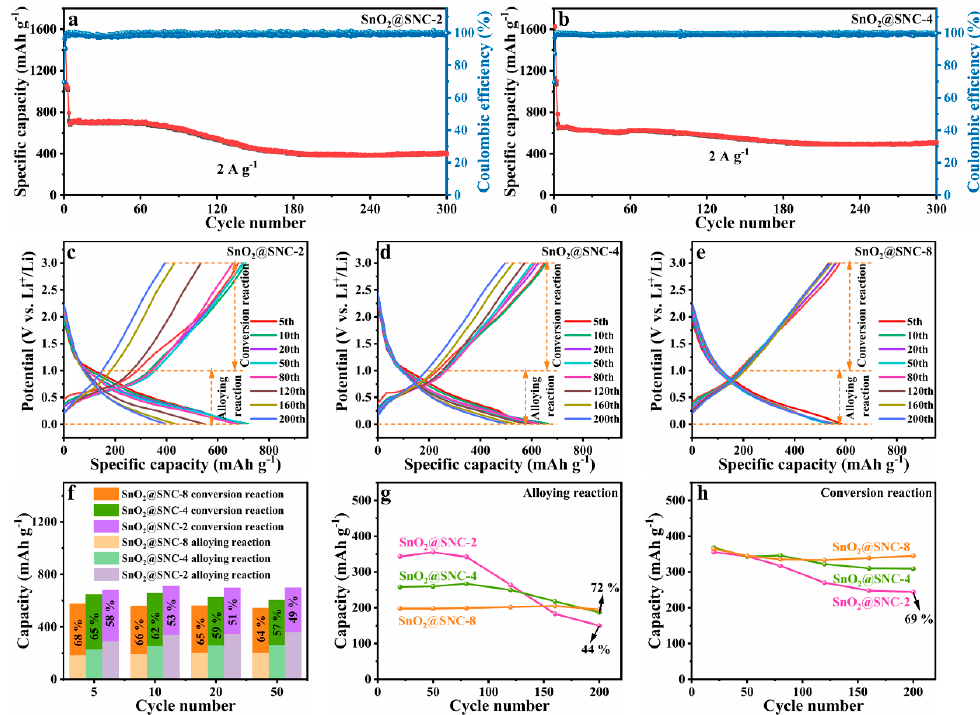
Figure 6. Long cyclic performance at 2 A g − 1 for the ( a ) SnO 2 @SNC − 2 and ( b ) SnO 2 @SNC − 4. GCD profiles at 2 A g − 1 for the ( c ) SnO 2 @SNC − 2, ( d ) SnO 2 @SNC − 4 and ( e ) SnO 2 @SNC − 8 at the 5th, 10th, 20th, 50th, 80th, 120th, 160th and 200th cycle. ( f ) The capacity contribution of SnO 2 @SNC − 2, SnO 2 @SNC − 4 and SnO 2 @SNC − 8 from the process of conversion reaction and alloyed reaction at the 5th, 10th, 20th and 50th cycle. The capacity retention of ( g ) alloying reaction and ( h ) conversion reaction at 2 A g − 1 for the three samples.